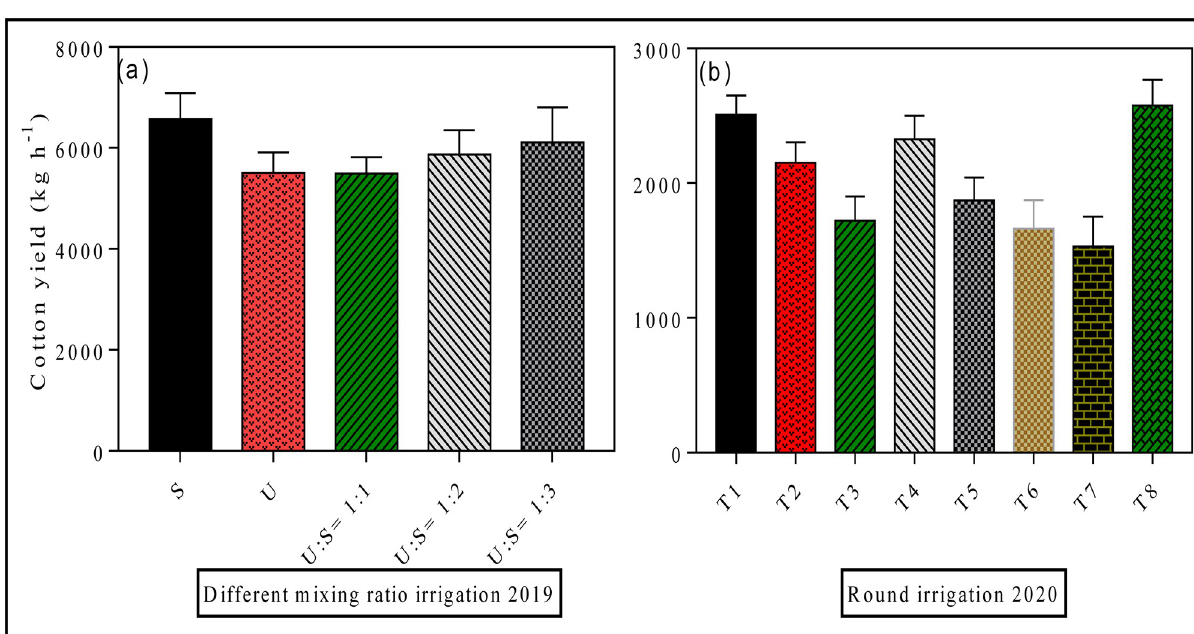
Fig 10. Effects of different irrigation methods on cotton yield. Data were presented as the mean ± standard error (SE) of three replicates at a significance level of p < 0.05 (based on ANOVA).